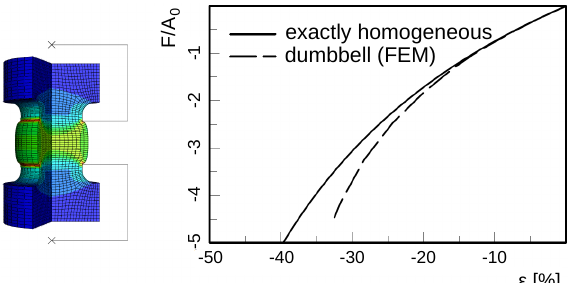
Figure 1. Inhomogeneous deformation in compression for a dumbbell specimen, FE-simulation with evaluation (figure from [17], labelling in